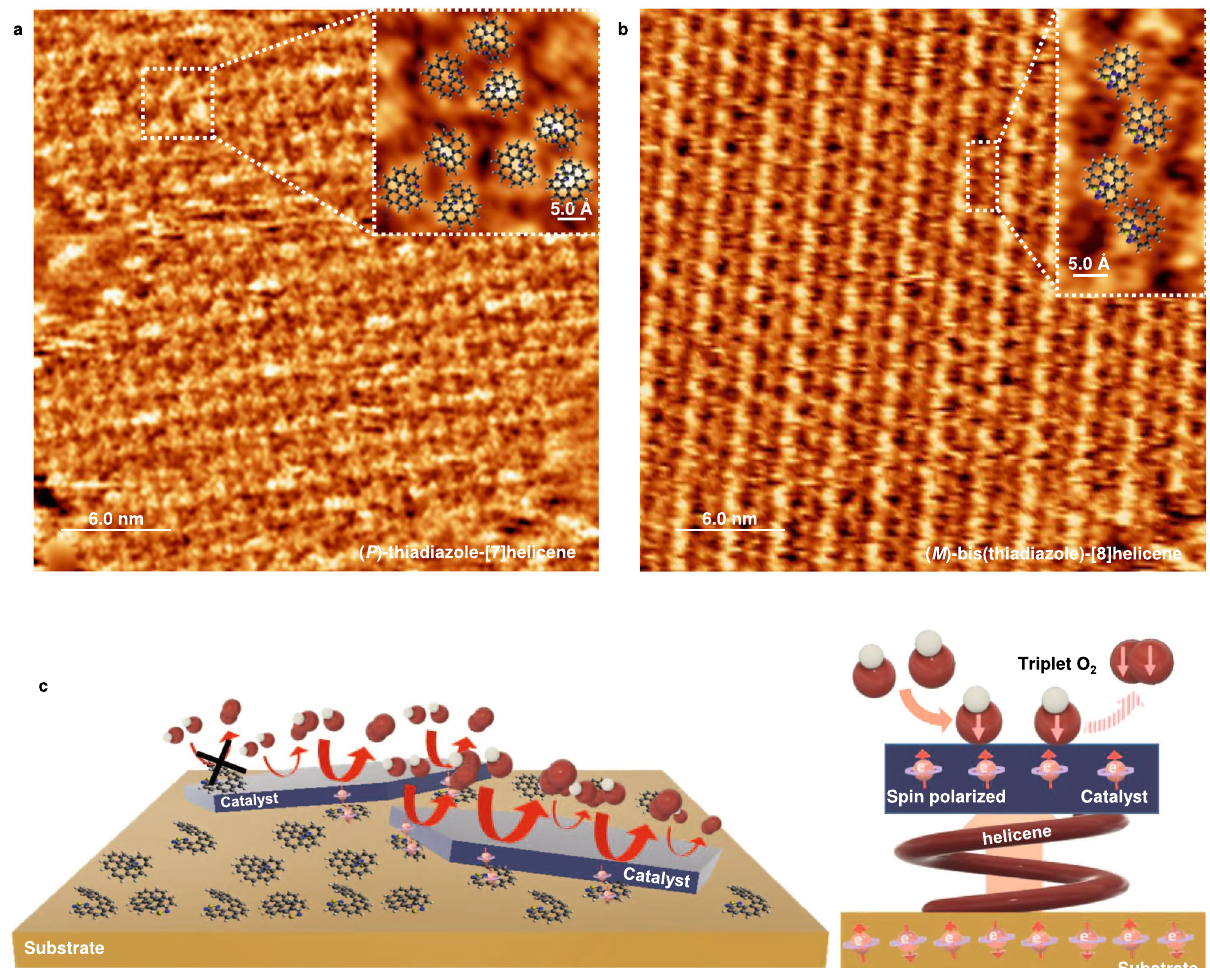
Fig. 4 Helicene SAM and effect on the OER activity. a An STM image of SAM of ( P )-thiadiazole-[7]helicene (image size: 30 nm × 30 nm, tunneling current: 25 pA, sample bias: − 5 mV). The dashed square marks three trimers of the molecules. A high-resolution image (image size: 4 nm × 4 nm, tunneling current: 20 pA, sample bias: 20 mV) showing three trimers is in the inset. b An STM image of SAM of ( M )-bis(thiadiazole)-[8]helicene on Au(111) (image size: 30 nm × 30 nm, tunneling current: 20 pA, sample bias: 25 mV). The dashed rectangle marks two dimers of the molecules. The inset shows a high-resolution image (image size: 3 nm × 4 nm, tunneling current: 20 pA, sample bias: − 25 mV) of two dimers. The 3D models of the molecules show the locations of the molecules. c Chiral molecule effect on the OER activity of NiO x islands dependent on the catalyst-chiral molecule-Au substrate con fi guration and illustration of the chiral molecular spin polarization effect on the